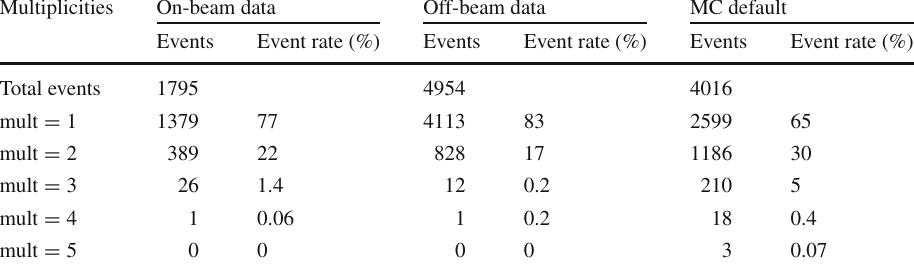
Table 2 Selected number of events from the on-beam data, off-beam data, and MC default samples and their corresponding acceptance rates on the multiplicity basis